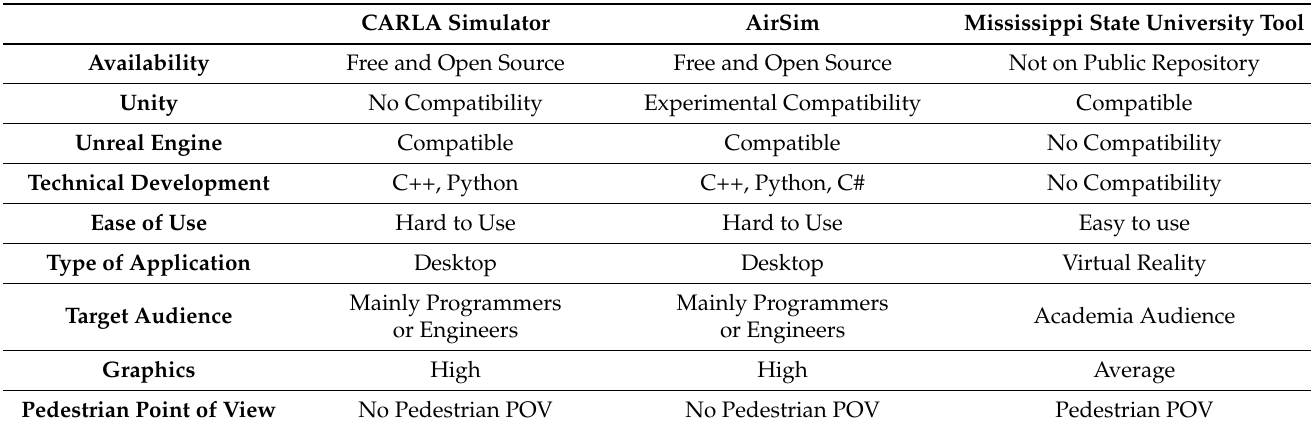
Table 1. Comparison among three significant pedestrian–AV interaction simulators on topics ranging from game engine and development complexity, to usability and technical audience, to visual fidelity of virtual environments, and to pedestrian point of